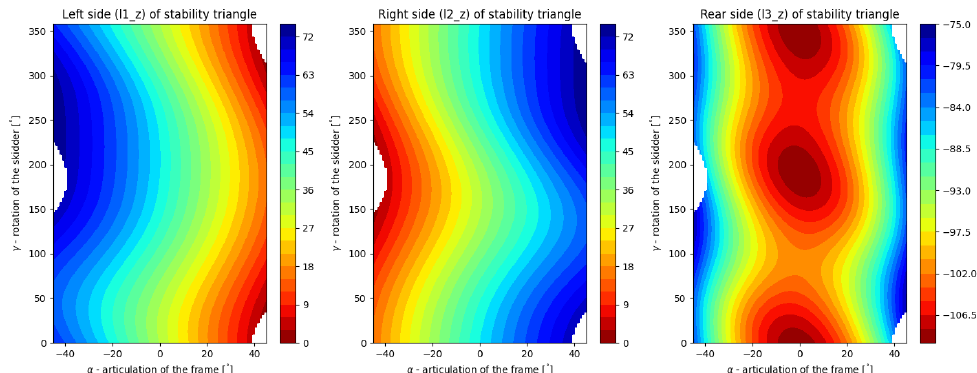
Figure 13. Comparison of stability for the half-filled tank (C3 config.) and the same tank with additional front load (C5 config.) Color bars show values computed as C3 minus C5 distances [mm] of gravity vector to tipping lines. Positive values mean that the C3 configuration is more stable than C5. Negative values mean that the C5 configuration is more stable than